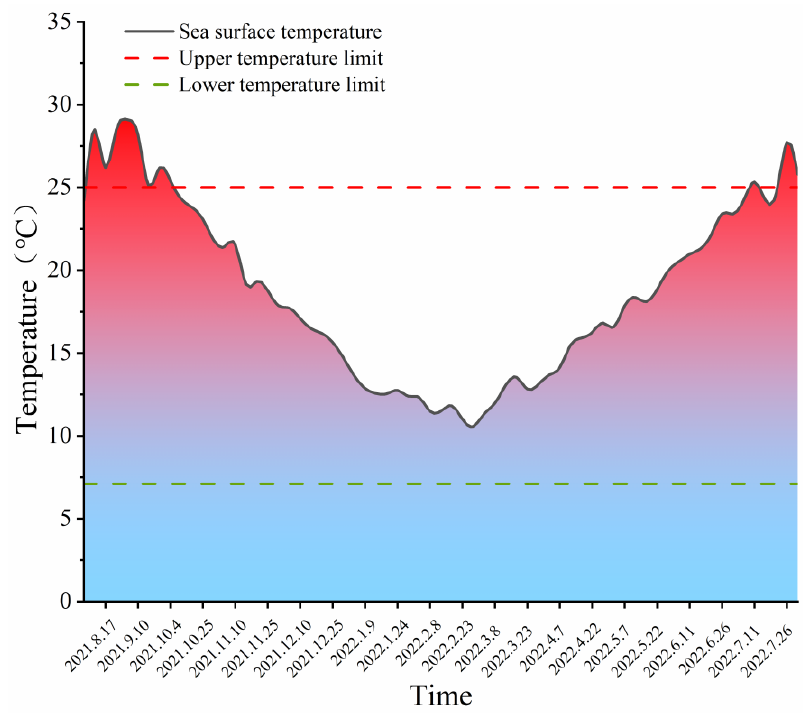
Figure 2. Variation of SST in Gouqi Island from August 2021 to July 2022.